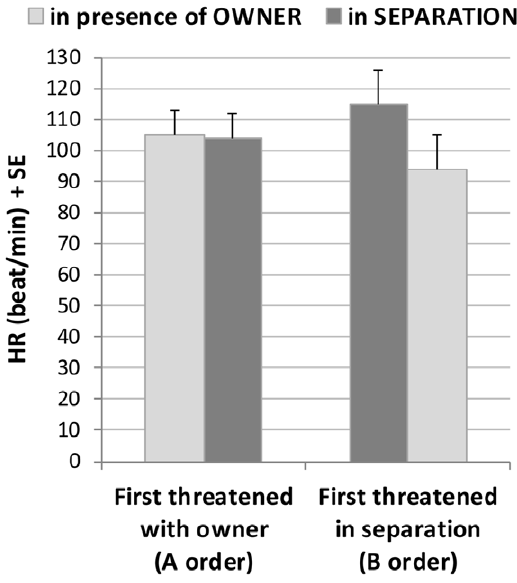
Figure 3. Effects of the test order on the HR in behaviourally reactive dogs. Changes in the mean heart rate (HR) of dogs that were reactive to the stranger in the episodes of the threatening encounter in the presence and absence of the owner in the two orders (A order: N=8, B order: N=9).